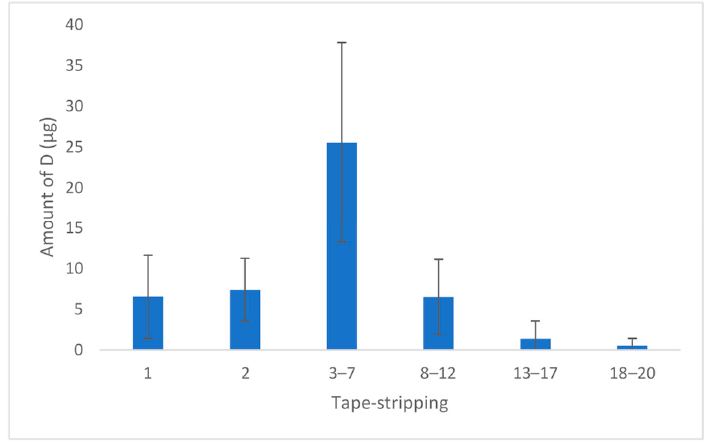
Figure 2. Amount of D per strip ( n = 5). The results show the mean and standard deviation. Table 2. Amount of skin retired (mg) for each group strip ( n = 3) with its standard deviation. Strip Mean (mg)